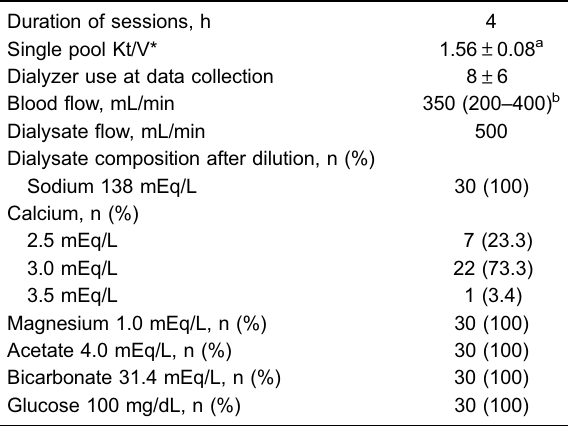
Table 1. Characteristics of dialysis